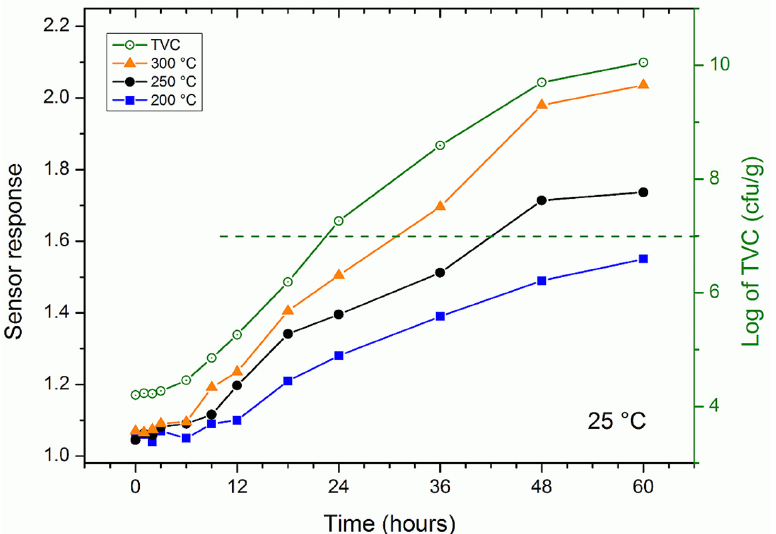
Figure 4. Sensor response (solid symbols, left scale) and bacterial population (green open circles, right scale) in fresh trout fish kept at room temperature (25 °C) over a period of 60 h.